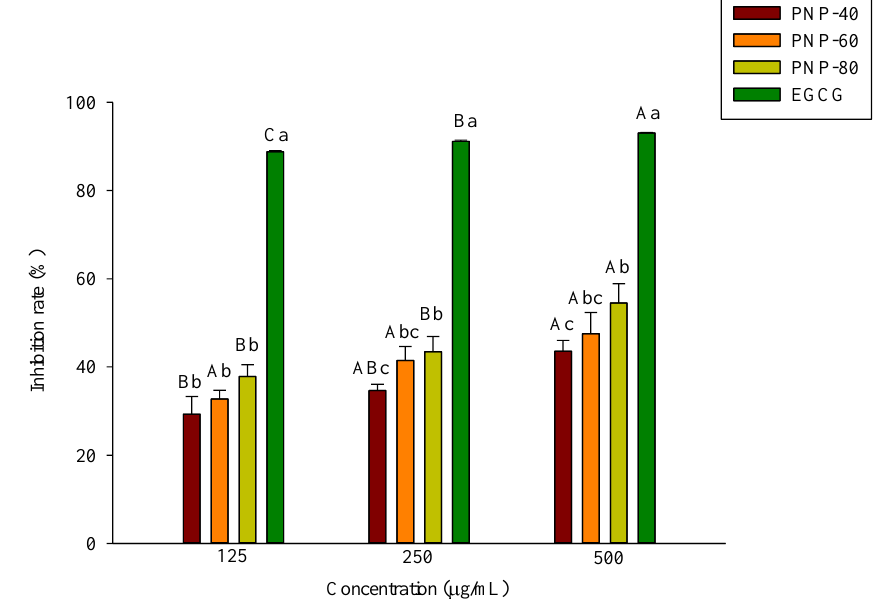
Figure 1. Anti-elastase activity of PNPs (125, 250, and 500 µ g/mL) and EGCG (125, 250 and 500 µ g/mL). Experiments were conducted in triplicate ( n = 3). Data are expressed as the mean ± SD. a–c: Matching lowercase letters between samples at the same concentration indicate significant differences between the samples at that concentration ( p < 0.05). A–C: Matching uppercase letters for the same sample at different concentrations indicate significant differences for that sample between different concentrations ( p < 0.05).